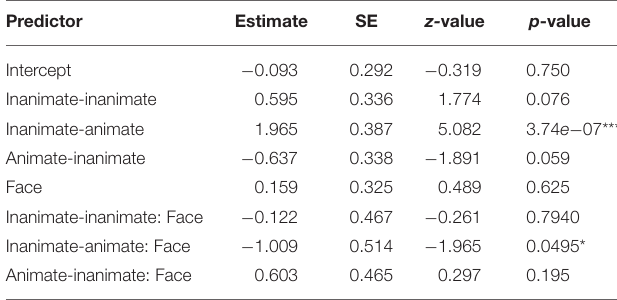
TABLE 4 | Adult verbal response results: Mixed-effects modeling of verbal response to comprehension questions indicating subject noun vs. object noun interpretation of ambiguous